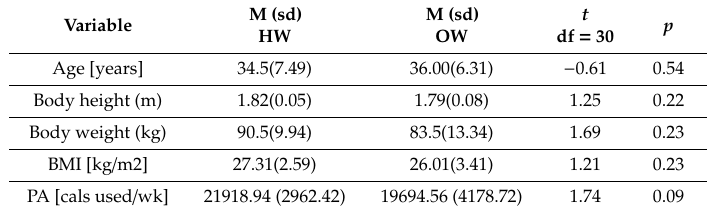
Table 1. Average values, standard deviations and di ff erences between groups for the general characteristics of the participants and physical activity before the start of the